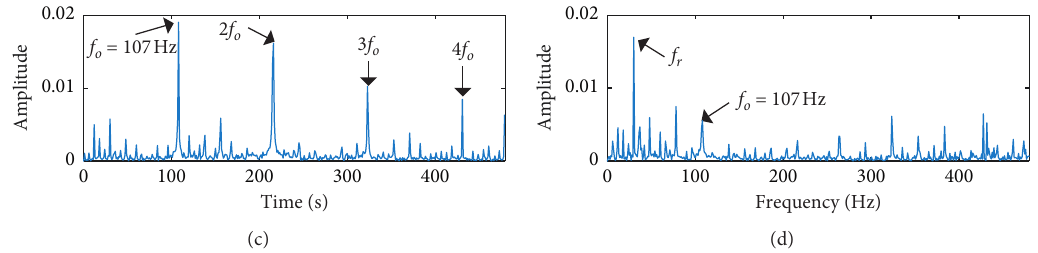
Figure 24: Results of the experimental data in Figure 21(a) by different ICF locating methods: (a) optimal mode extracted by the proposed method and (c) its envelope spectrum; (b) optimal mode extracted based on EFS and (d) its envelope spectrum.